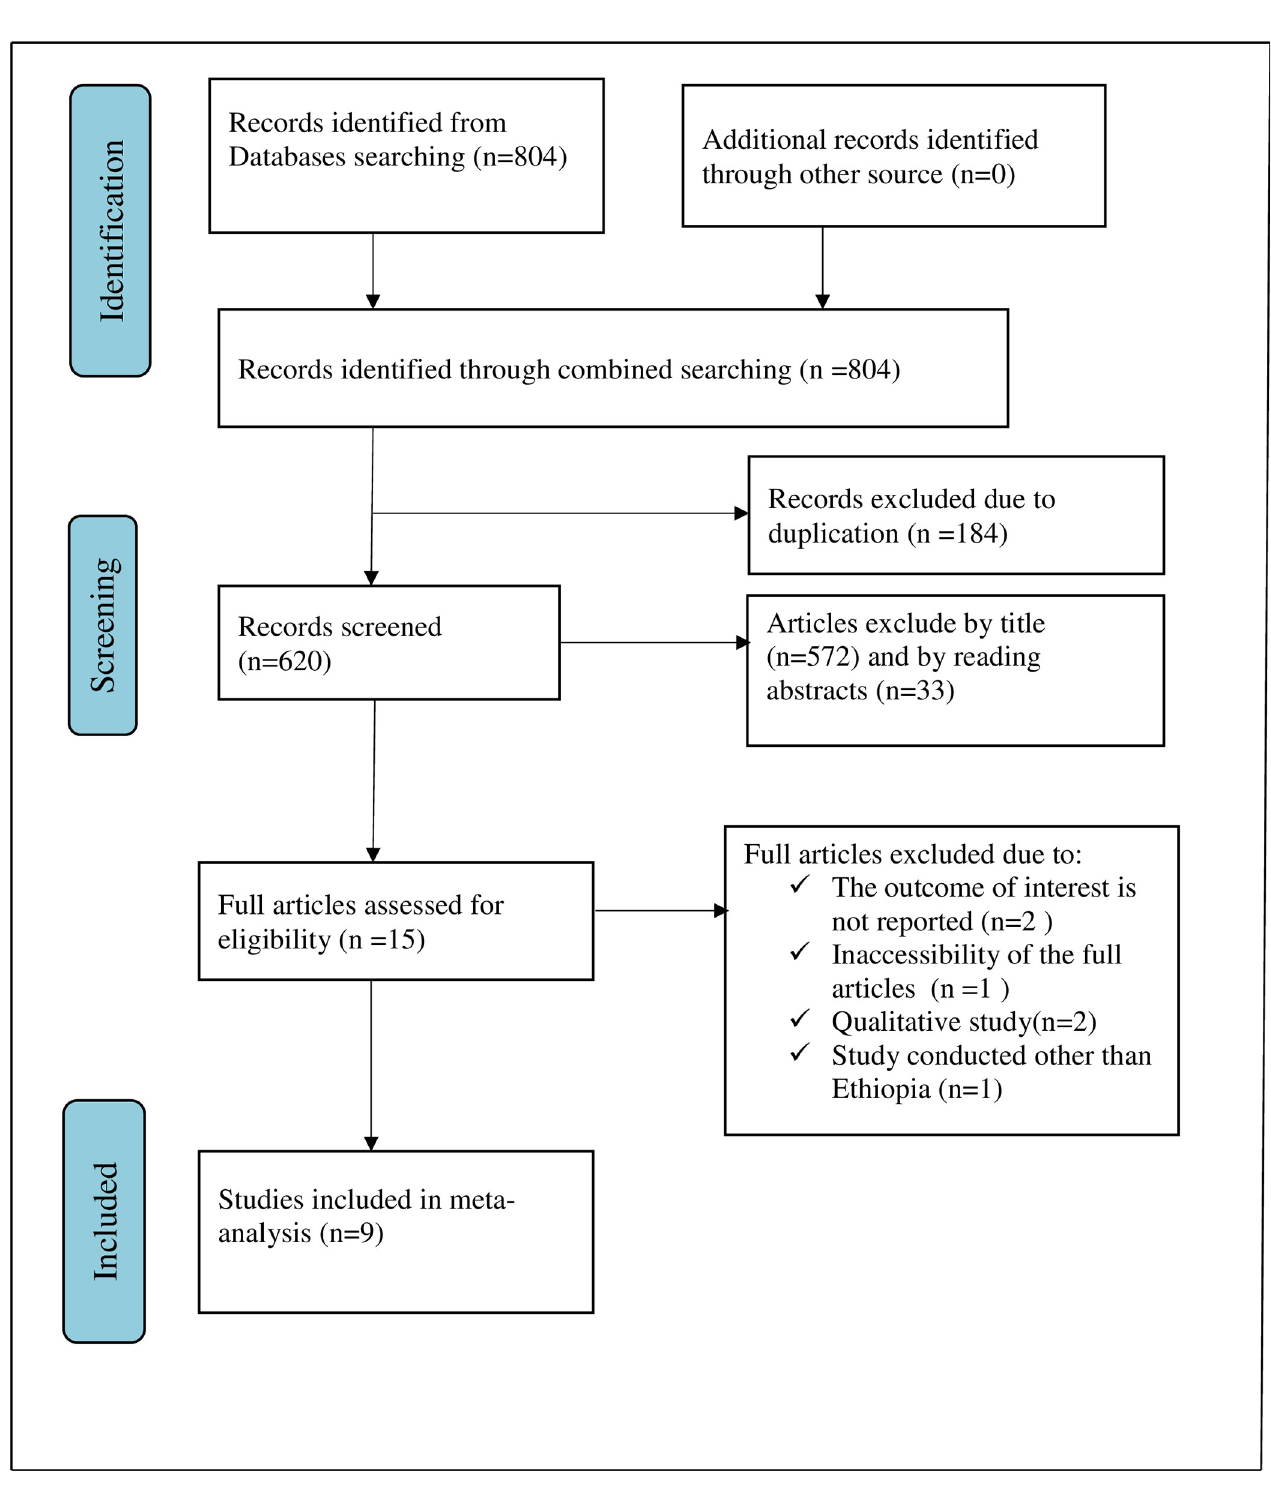
Fig 1. Flow chart of selection for systematic review and meta-analysis.